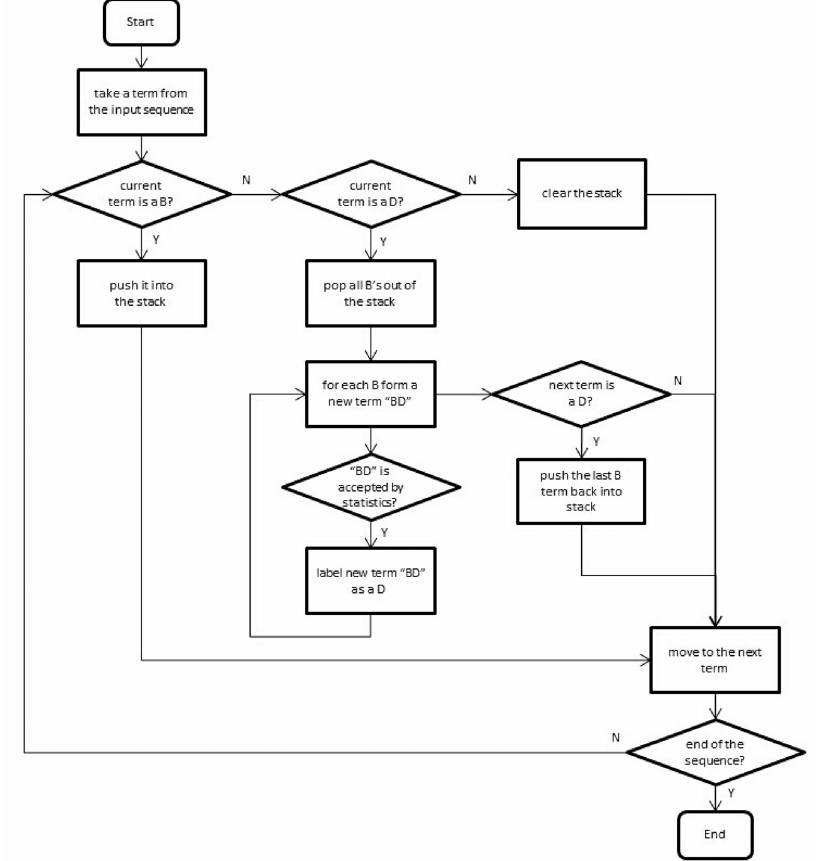
Fig 4. Dynamic term assembly using body part